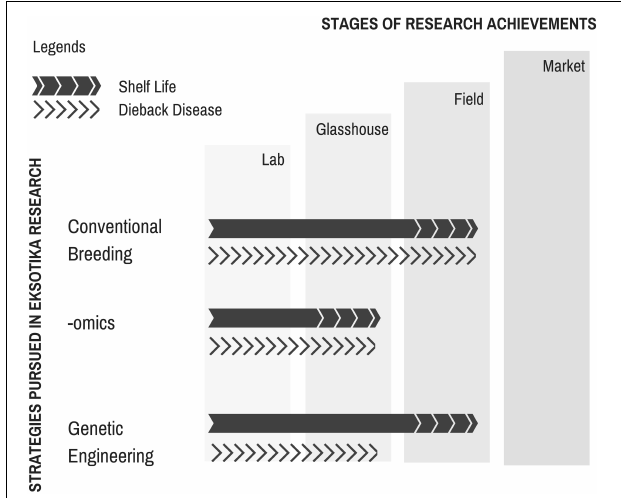
FIGURE 4 | Summary of research work conducted on Carica papaya L. var. Eksotika in